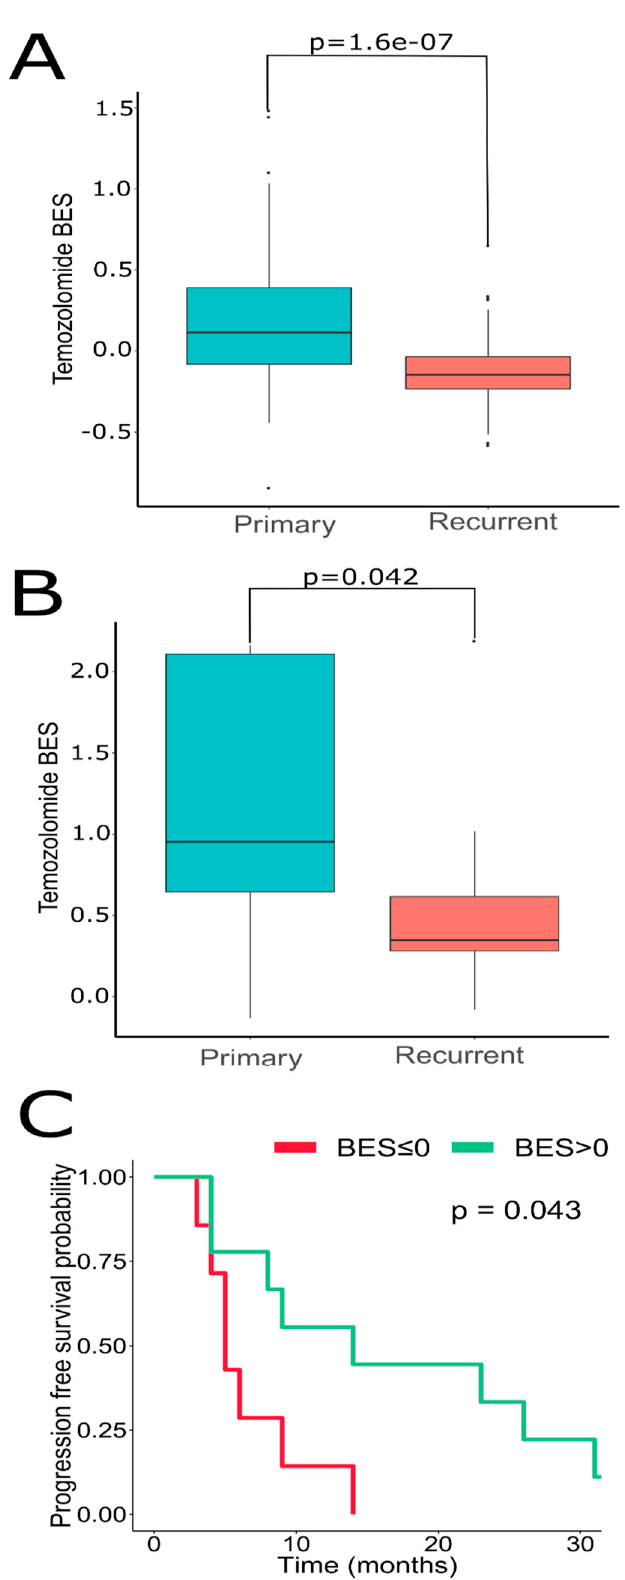
Figure 7. Oncobox BES for TMZ is higher in ndGB vs. recGB sets for both ( A ) GB tissues, Wilcoxon test p -value = 1.06 × 10 − 7 ; and ( B ) GSCs, Wilcoxon p = 0.042. ( C ) Dependence of GB patient’s progression-free survival on Oncobox BES for Temozolomide, n = 16 patients with ndGB. Hazard ratio = 0.29 (95% CI, 0.088–0.96, p = 0.043) for patient level analysis. Hazard ratio = 0.18 (95% CI, 0.078–0.4, p < 0.0001) for individual sample level analysis. The analysis was performed using R ggsurvplot package.